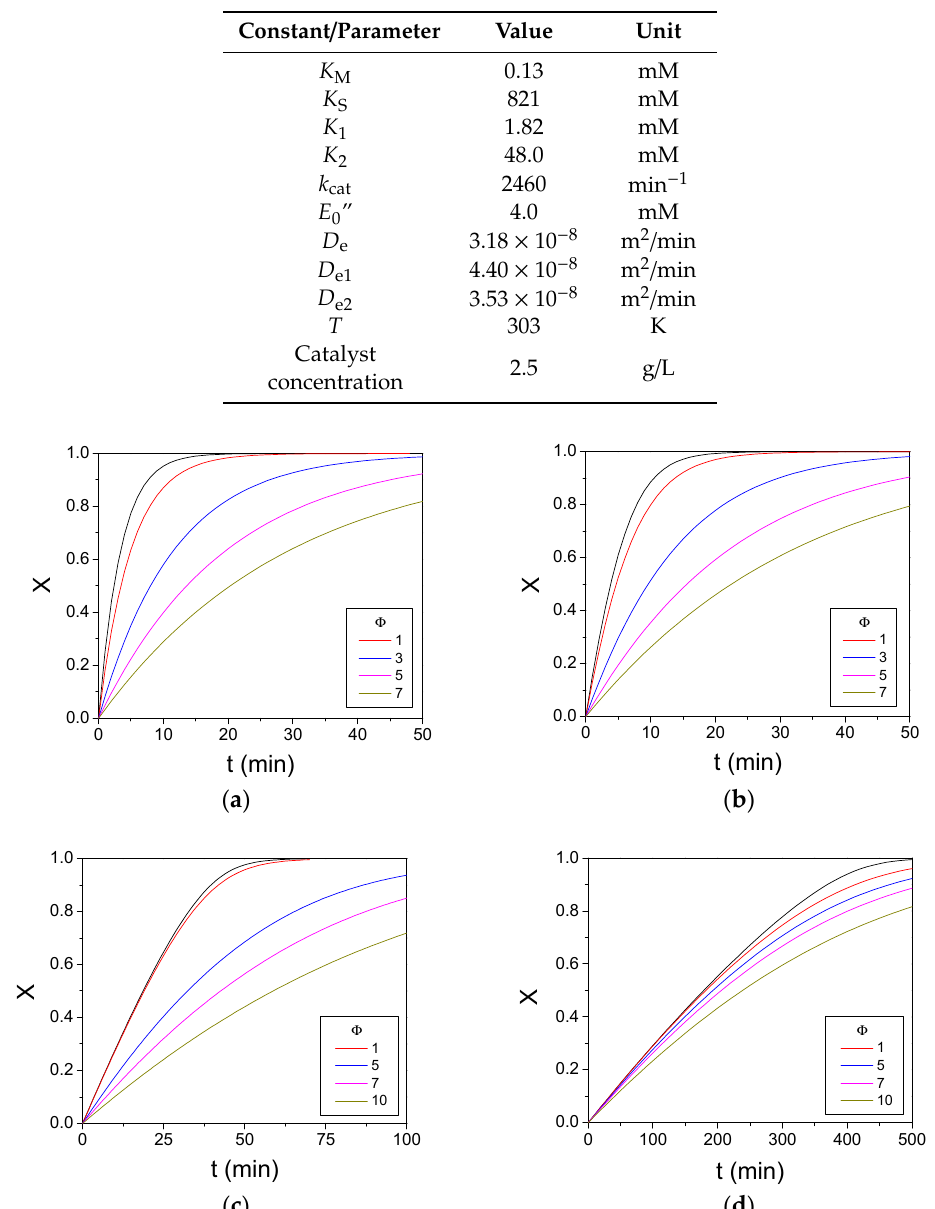
Table 4. Kinetic constants and parameters for the hydrolysis of penicillin G (PenG) by penicillin G acylase (PGA) at 30 ◦ C and pH 7.8.